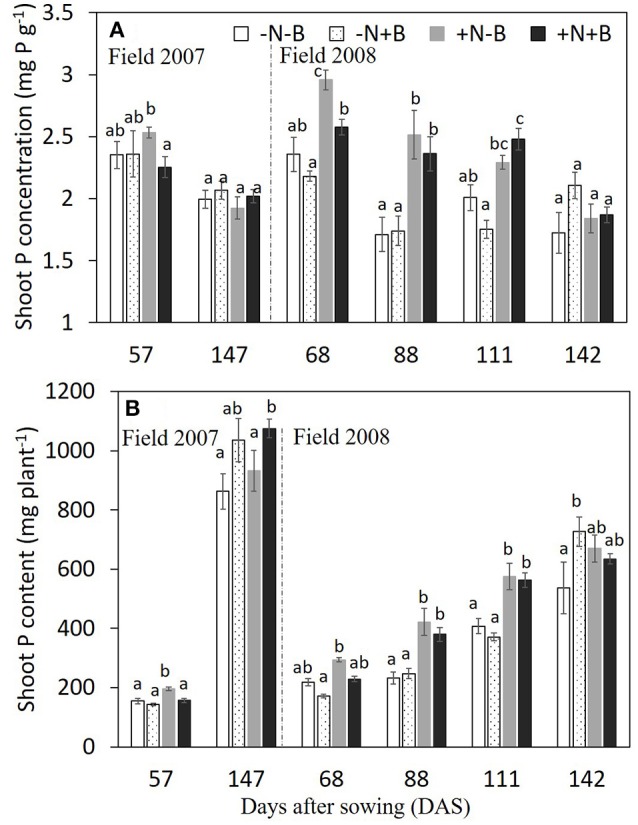
Effects of N fertilizer supplies and benomyl on shoot P concentration (A) and shoot P content (B) by maize at different growth stages in 2007 (and 2008). Each value is the mean of four replicates (±SE). Different letters denote significant difference (P < 0.05) among the treatments at each growth stage. –N–B: no N fertilizer and no benomyl; –N+B: no N fertilizer and benomyl; +N–B, N fertilizer and no benomyl; +N+B, N fertilizer and benomyl. DAS: days after sowing for years 2007 (2008) [57 (68) = jointing; 88 = silking; 111 = milk: 147 (142) = harvest].